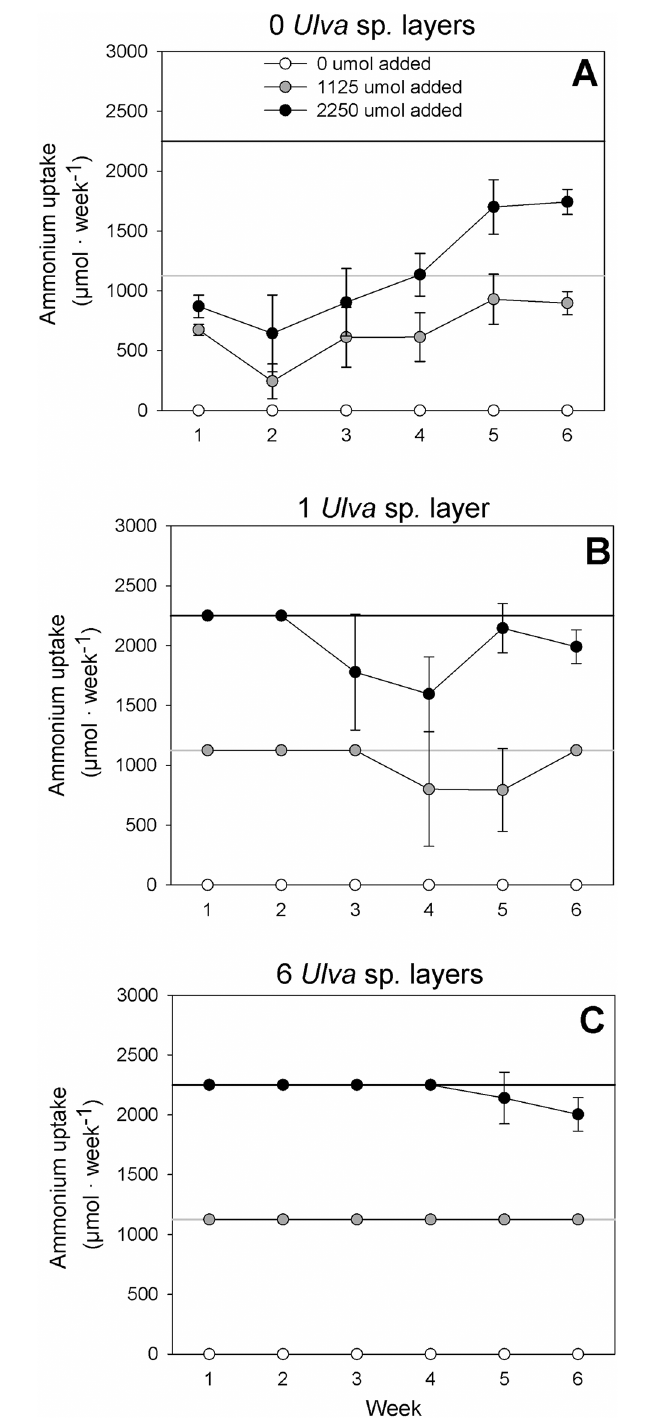
Fig 3. Removal (uptake) of ammonium from the water by autotrophs. A) No Ulva sp., B) 1 layer of Ulva sp., C) 6 layers of Ulva sp. Horizontal lines represent 100% removal of ammonium by autotrophs for the +N treatment (grey) and the +NN treatment (black), respectively. Mean values ± 95% confidence limits (n = 3).